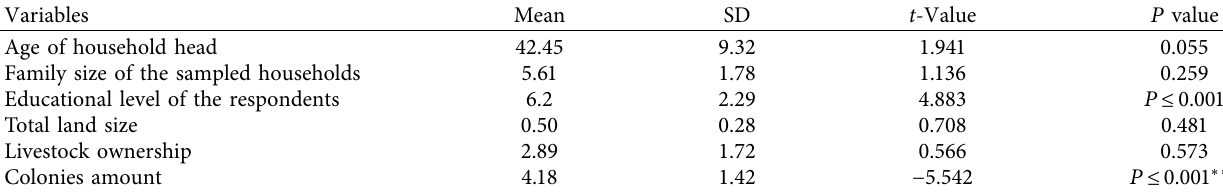
Table 17: Summary of t -test values for continuous variables.